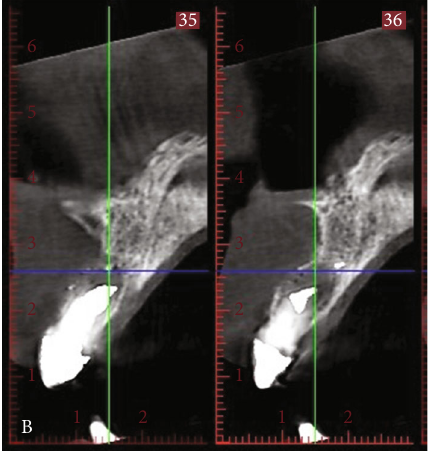
Figure 3: Preoperative sagittal CBCT view showing destruction of the buccal cortical layer of